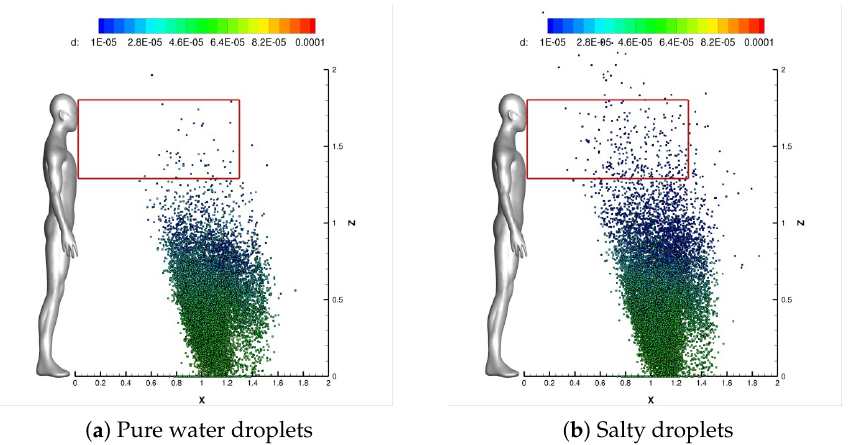
Figure 4. Cloud representation at t = 10 s. Parcels are colored with the particle